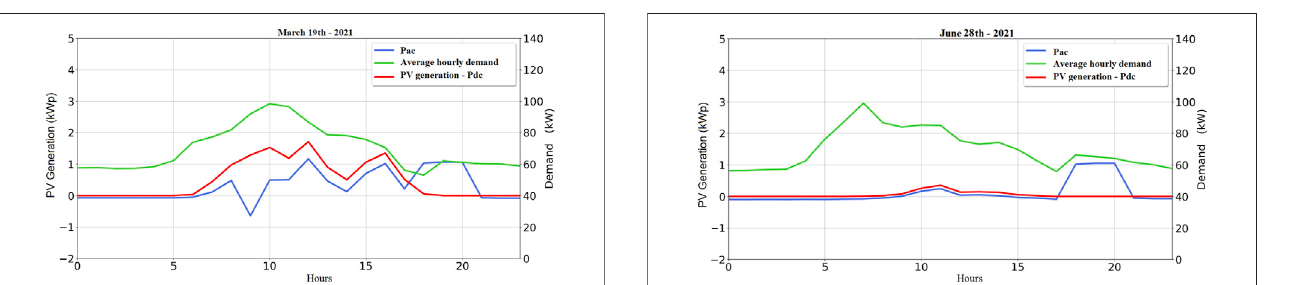
FIGURE 9 | The PV generation pro fi le with days of minimum hourly irradiation for the academic weekday – 06/28/2021 versus average hourly demand of June/2019. Data Sources: the